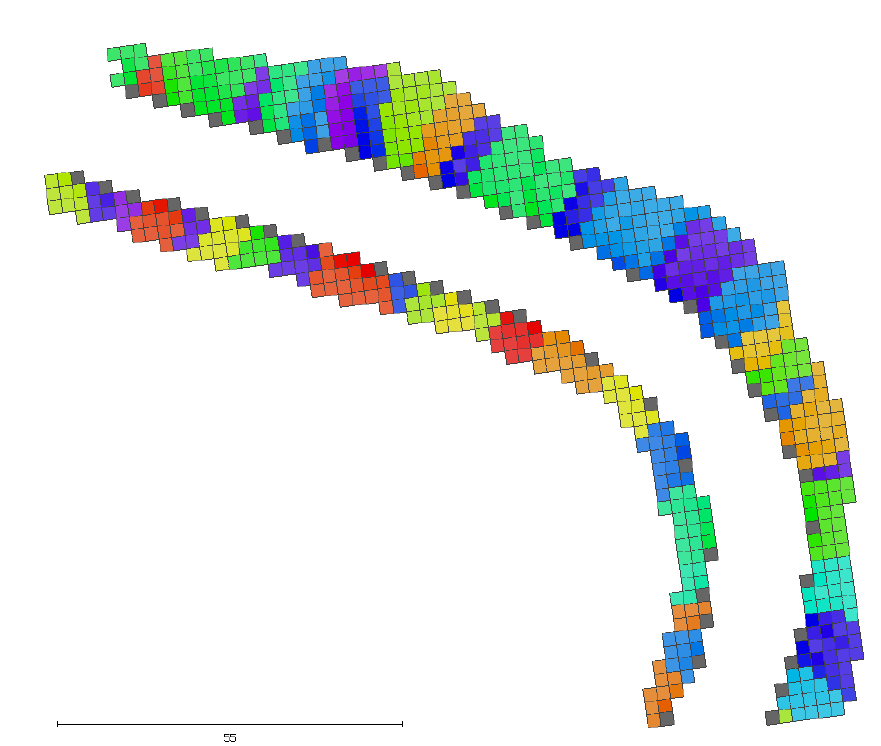
Figure 11: Accumulated inflow of each grid